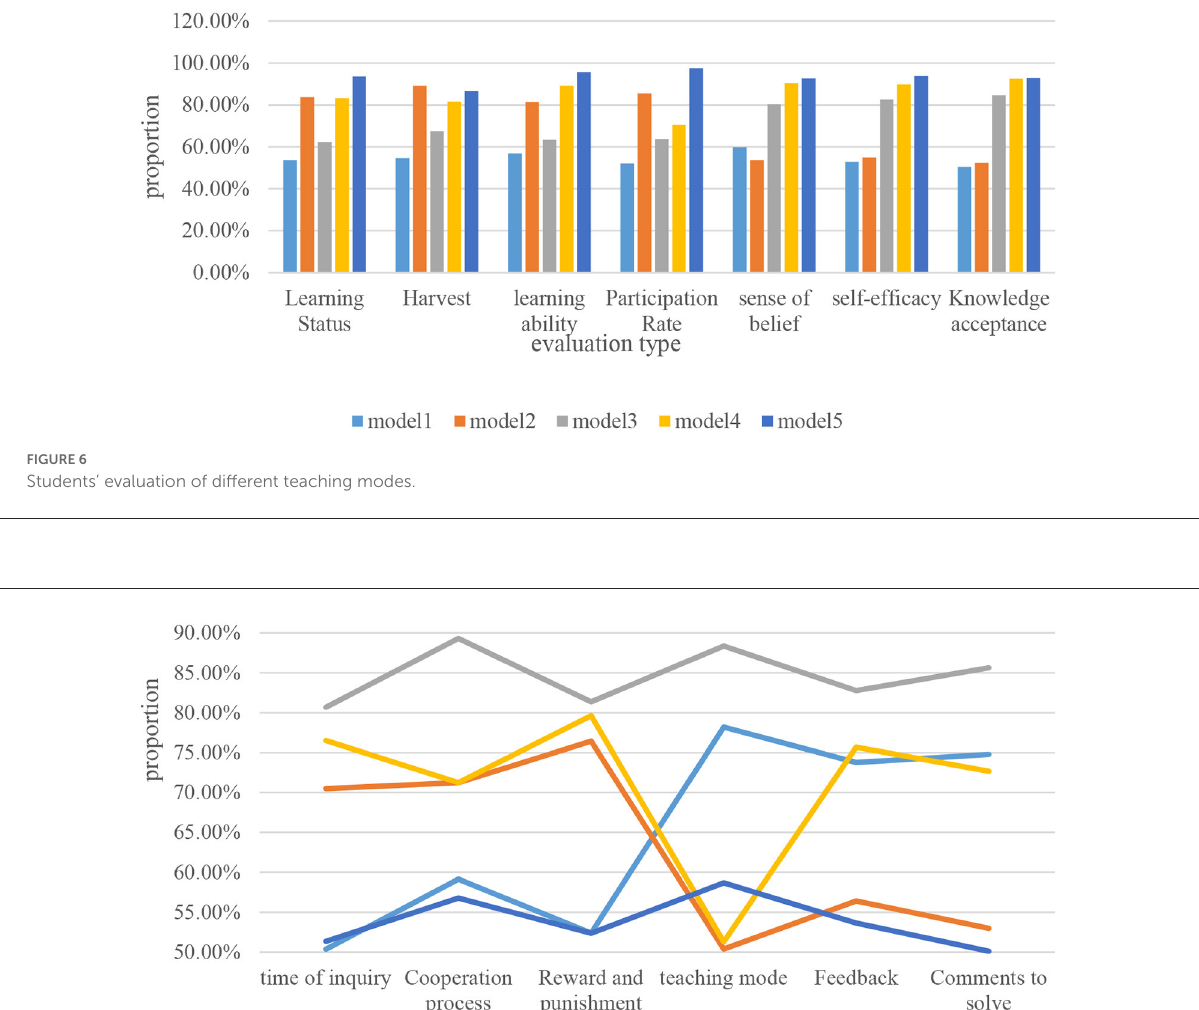
FIGURE7 Comparative analysis between different history teaching modes.